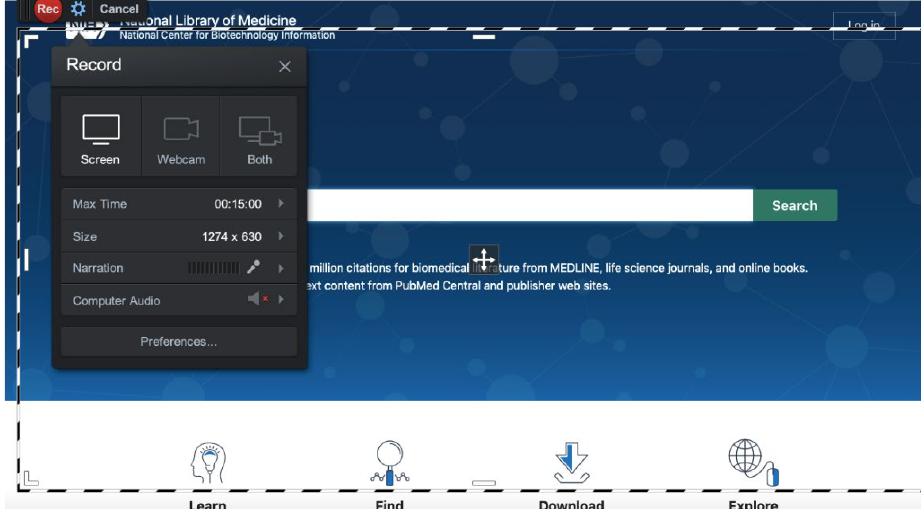
Figure 2 File saving/uploading, sharing, and editing